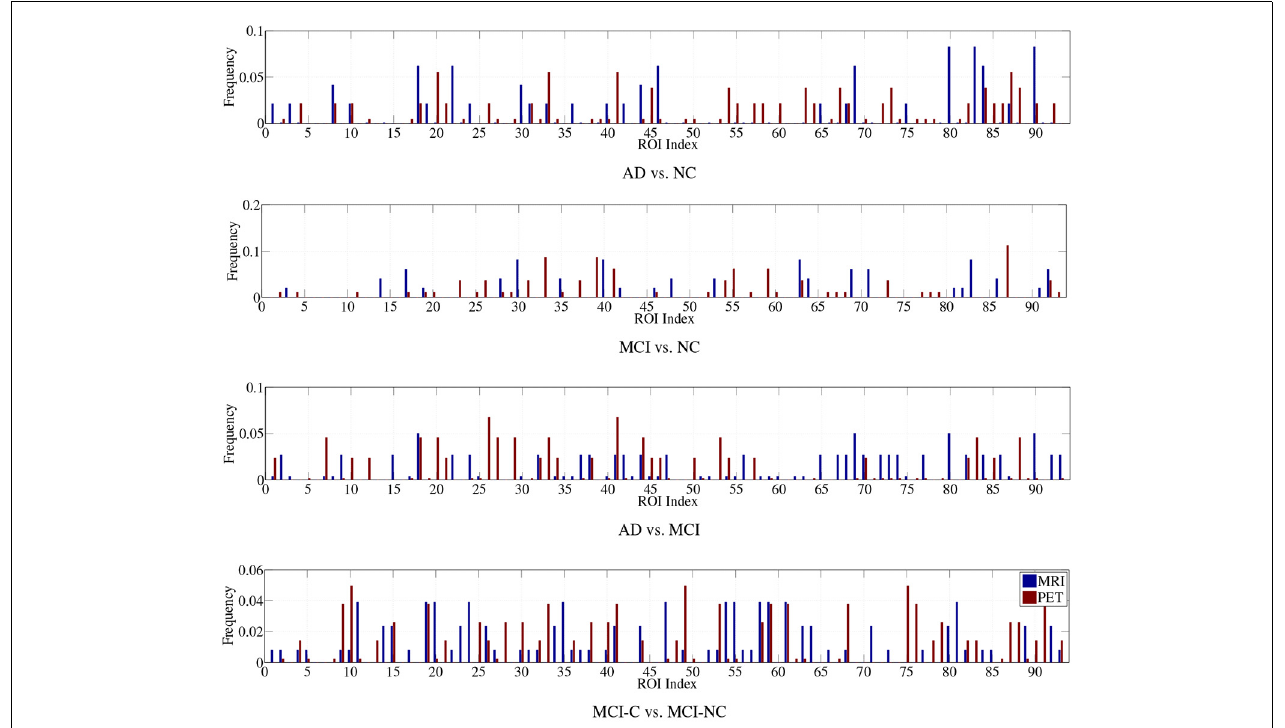
FIGURE 5 | Normalized histograms of the selected features in four binary classification